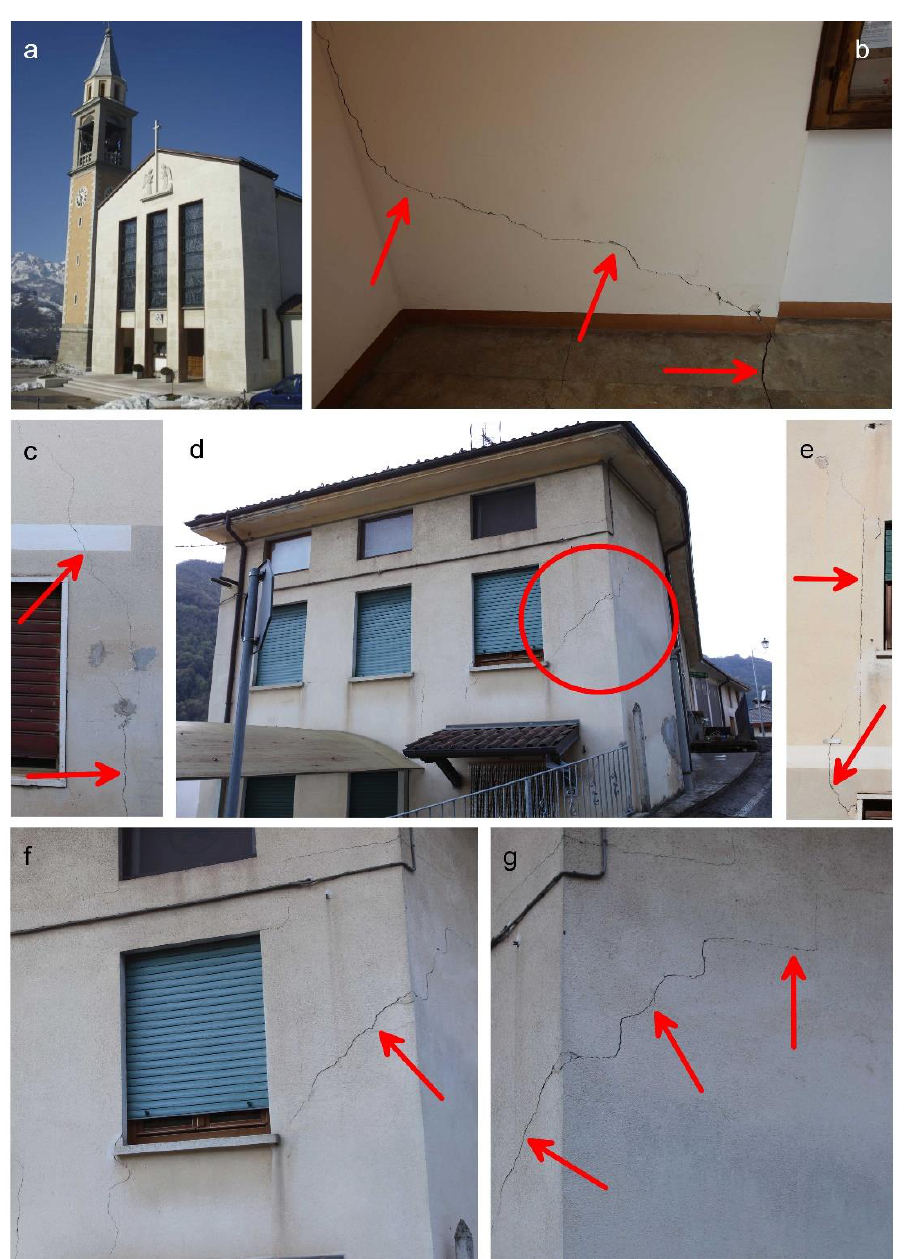
Figure 2. Pictures of Rovegliana Church ( a ) and one of the most damaged buildings in Cappellazzi district ( c – g ). In ( b ), a large crack in the portico of the church is